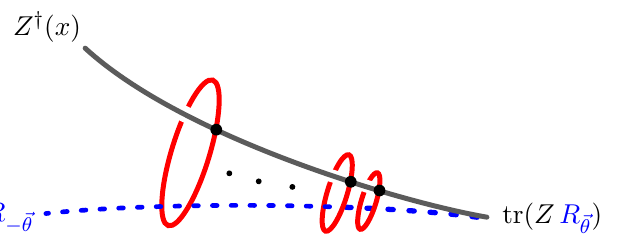
Figure 8 . Feynman graphs contributing to the wave function. The graphs can be drawn on a cylinder. The blue dashed line represents the cut used to twist the diagrams according to the rules of section 2. The black line is made of Z -propagators, and the red lines represent twisted X -propagators.